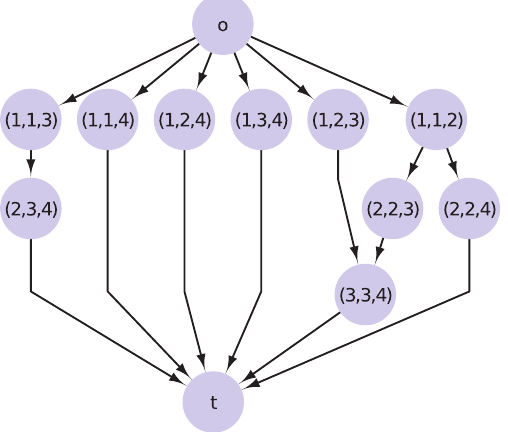
Figure 2. Directed acyclic graph (DAG) used as input in Algorithm 1 (Fig. 3). The DAG F for n ~ 4 time points is depicted. It contains f ~ 12 nodes, including the special nodes o and t . The label p , q , r of each node corresponds to the time points p , q , and r .